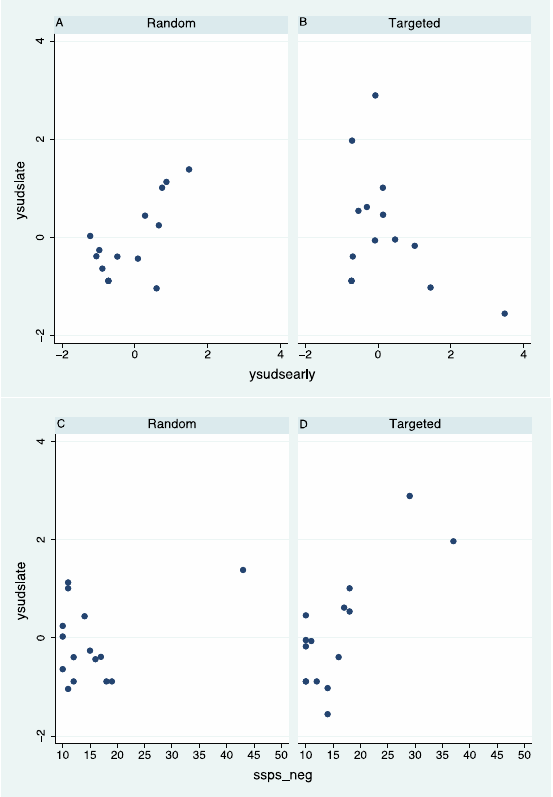
Figure 2. Scatter diagrams for the SUDS and SSPS_neg scores by condition (Random, Targeted). ( A,B ) Factor score ysudslate on ysudsearly. ( C,D ) Factor score ysudslate on